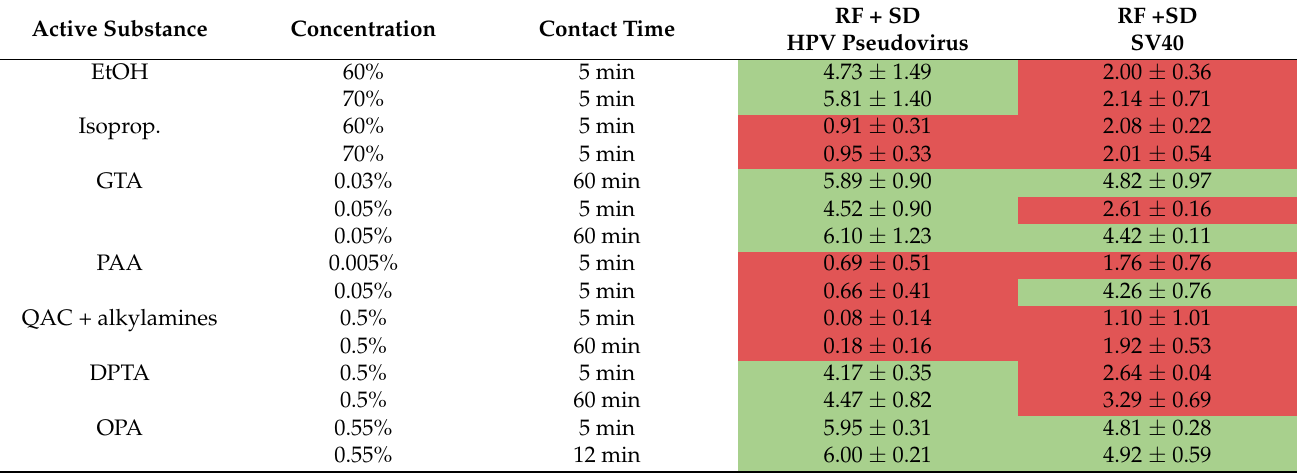
Table 2. Comparison of virucidal activity of chemical disinfectants against HPV16 pseudovirus and SV40. The selection was made based on the availability of the products on the market and the known concentrations of their active ingredients. The active substances of the used disinfectants, the concentration, the contact time, and the reduction factor (RF) values are listed. The RF (log 10 reduction of viral titer) was calculated as the difference between the remaining virus titer after exposure to disinfectant and unexposed virus. Shown is the average RF of three (HPV pseudoviruses) or six (SV40) independent experiments with standard deviation, respectively. Green background indicates a ≥ 4 log 10 reduction of virus titer corresponding to a viral inactivation of >99.99%, red background indicates a RF < 4 log 10 . Tests were performed at 20 ◦ C ± 2 ◦ C with 0.3 g/L BSA as the interfering